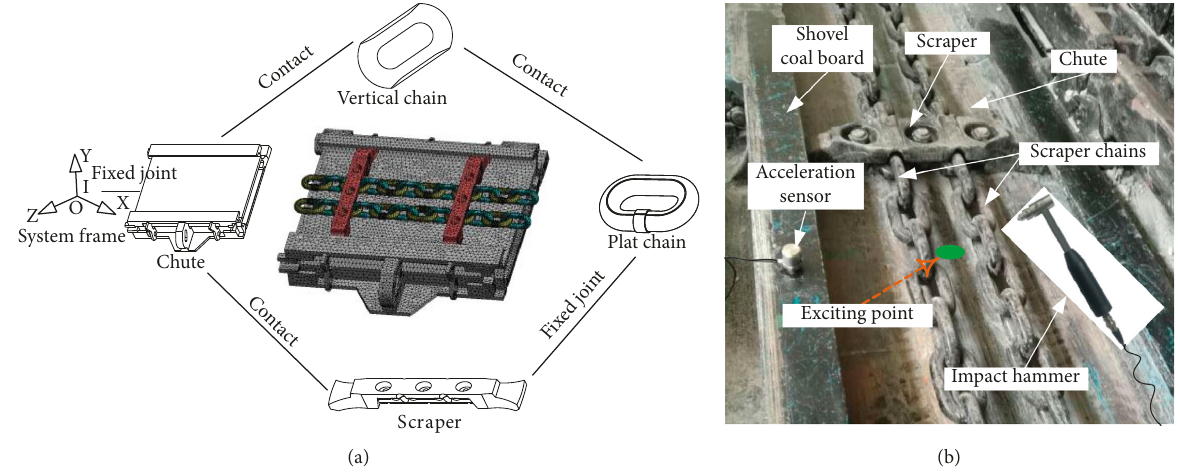
Figure 2: Descriptions of modal analysis based on (a) the CVM and (b) the HIT.